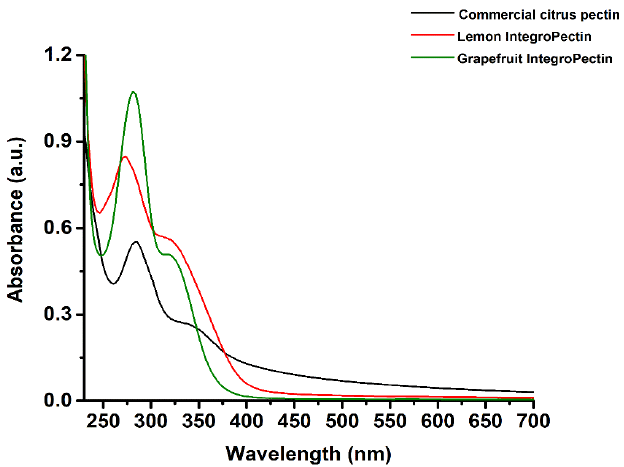
Figure 1. Absorbance spectra of commercial citrus pectin, lemon, and grapefruit IntegroPectins.